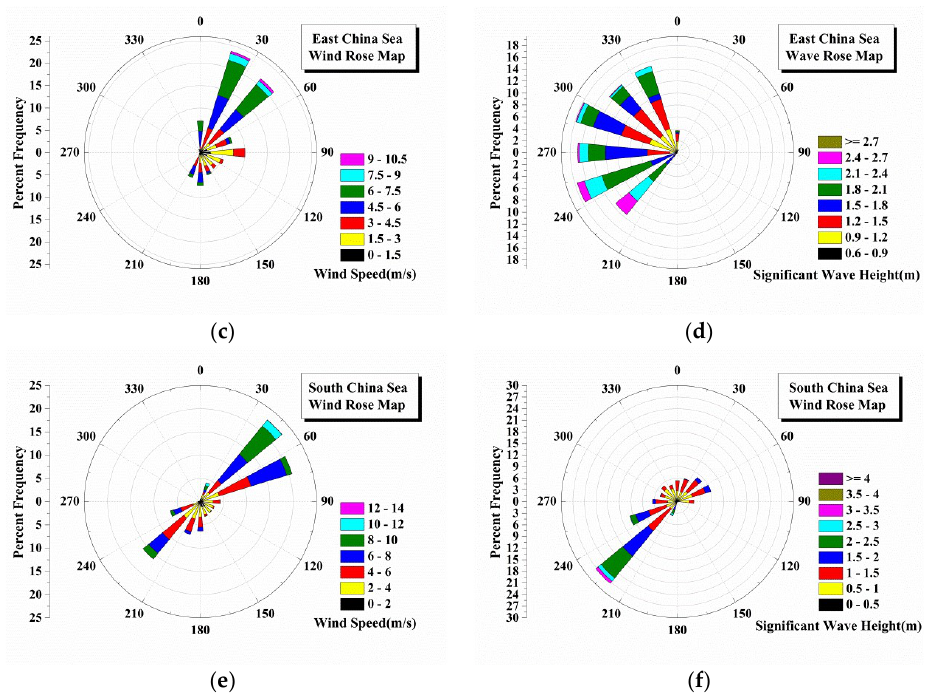
Figure 2. The rose map of wind speed and significant wave height in china offshore seas: Yellow Sea ( a ) Wind speed; ( b ) Significant wave height; East China Sea ( c ) Wind speed; ( d ) Significant wave height; South China Sea ( e ) Wind speed; ( f ) Significant wave height.